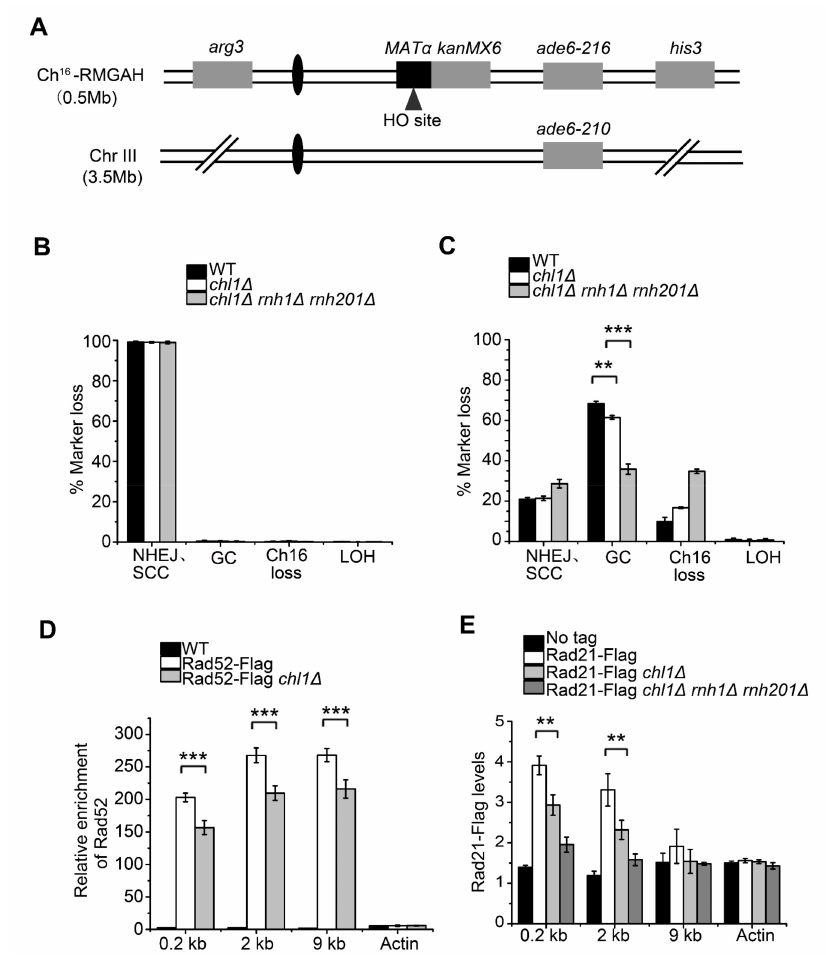
Figure 4. Chl1 influences DNA repair efficiency by HR pathway: ( A ) Schematic of minichromosome Ch16-RMGAH. The MAT α on the right arm of Ch 16 containing an HO endonuclease recognition site is adjacent to kanMX6 , a G418 resistance marker gene, together with a centromere-distal his3 gene. The ade6-M216 heteroallele on Ch 16 is complemented by ade6-M210 on Chr III. An arg3 marker is on the left arm of Ch 16 . Derepression of HO endonuclease gene by removal of thiamine generates DSB at the MAT α recognition site; ( B , C ) The percentage of cells with marker gene loss before and after HO endonuclease induction was calculated. The levels of GC, NHEJ/SCC, Ch16 loss, and LOH are presented; ( D ) ChIP–qPCR demonstrated that Chl1 deletion reduced Rad52 accumulation at locations 0.2, 2, and 9 kb from the HO cleavage site with the induction of HO endonuclease for 22 h; ( E ) ChIP–qPCR demonstrated Rad21 levels in the indicated strains at locations 0.2, 2, and 9 kb from the HO cleavage site after 22 h induction of HO endonuclease. Mean ± SEM of 3 replicates is shown. ***, p < 0.001; **, p < 0.01, Student’s t